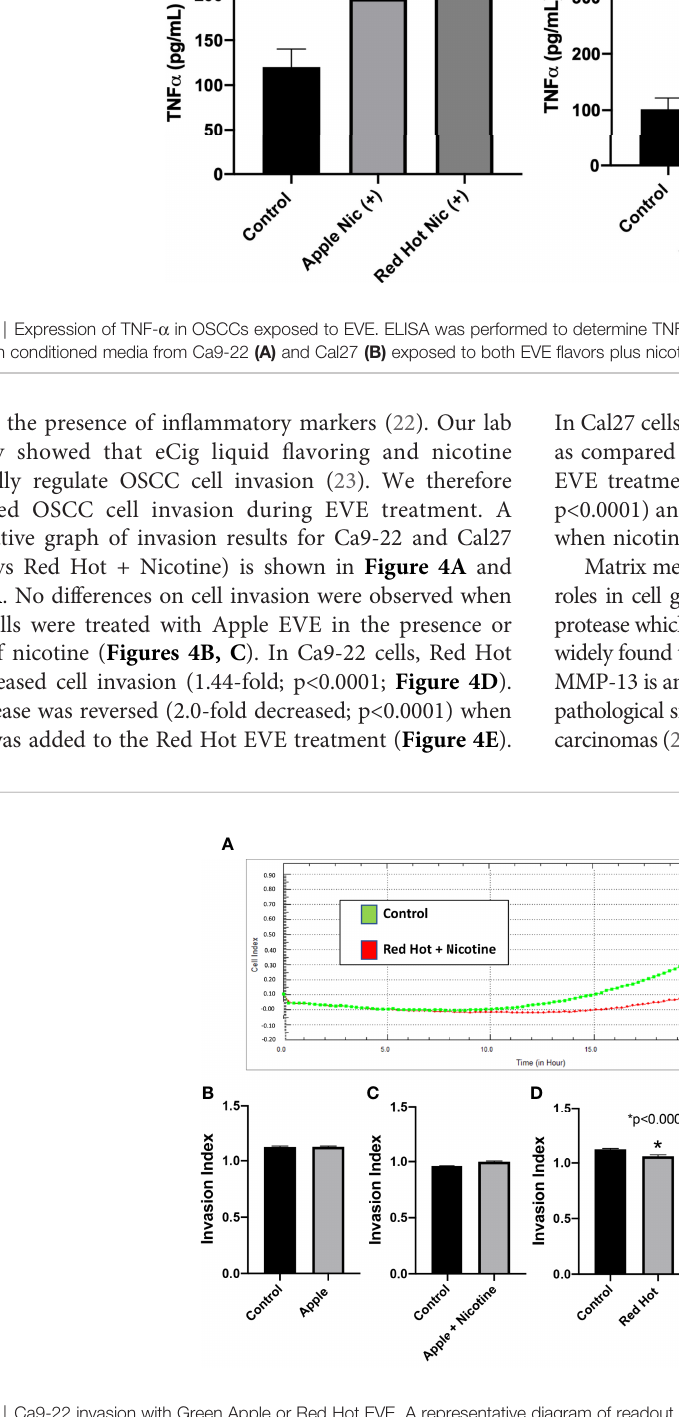
FIGURE 4 | Ca9-22 invasion with Green Apple or Red Hot EVE. A representative diagram of readout cells over time invasion is shown in (A) . At 24 hours of culture, Green Apple EVE did not affect Ca9-22 invasion with or without nicotine (B, C) . Treatment with Red Hot EVE decreased Ca9-22 invasion (D) and Red Hot with nicotine enhanced Ca9-22 invasion (E) when compared to c untreated controls. Data are shown with *p ≤